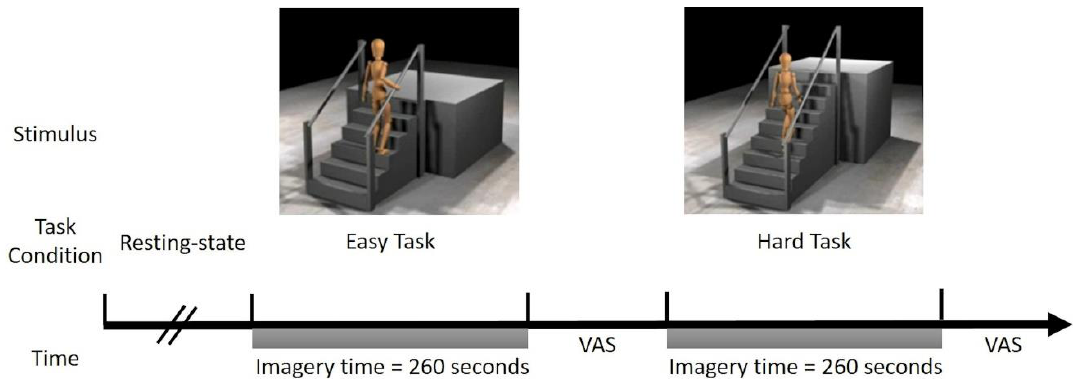
Figure 1. A single resting-state run was completed prior to the start of the motor imagery (MI) task. The order of the tasks was randomized across the participants; half the participants completed the Easy Task first and the other half the Hard Task. Participants were instructed to visualize themselves as the avatar in the videos as it completed a series of movements. Each task was played for 260 s. After each task, the participants completed self-report questions using a visual analog scale